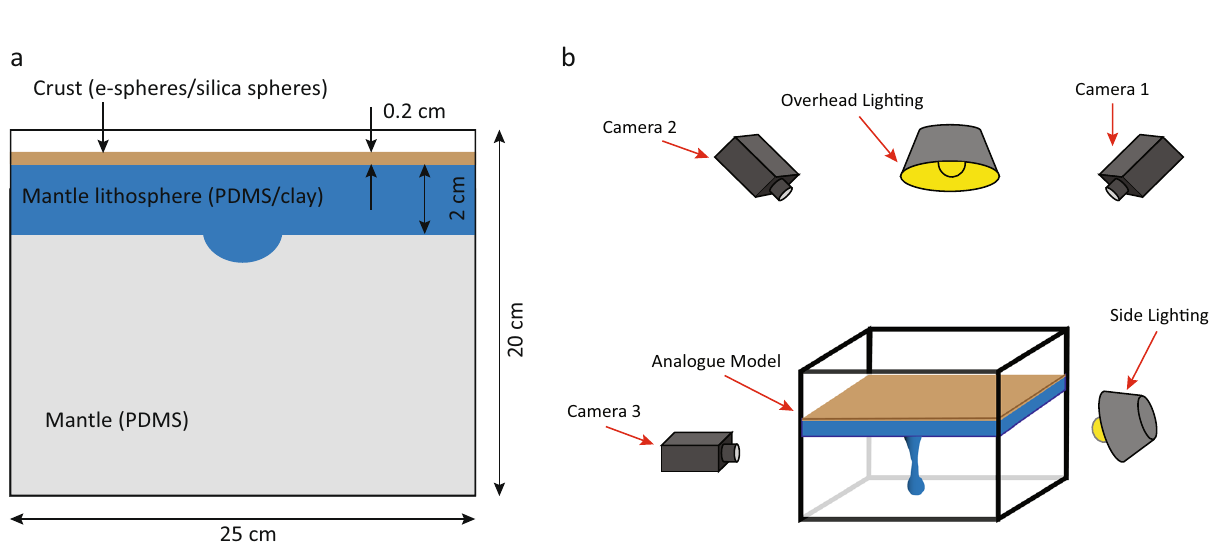
Fig. 6 Schematic illustration of experimental setup. a Analogue model dimensions and materials. Modi fi ed from ref. 40 . b Experimental setup and camera